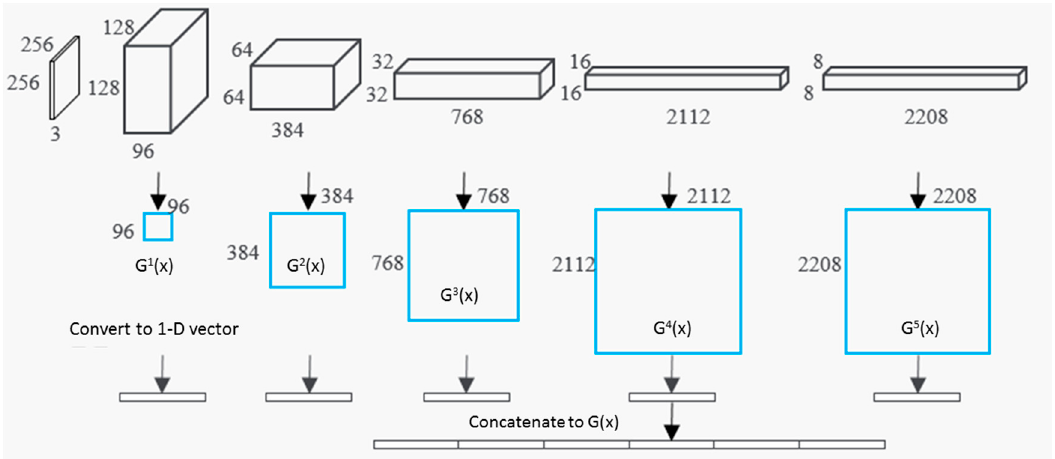
Figure 6. The Gram matrices extracted from DenseNet-161.